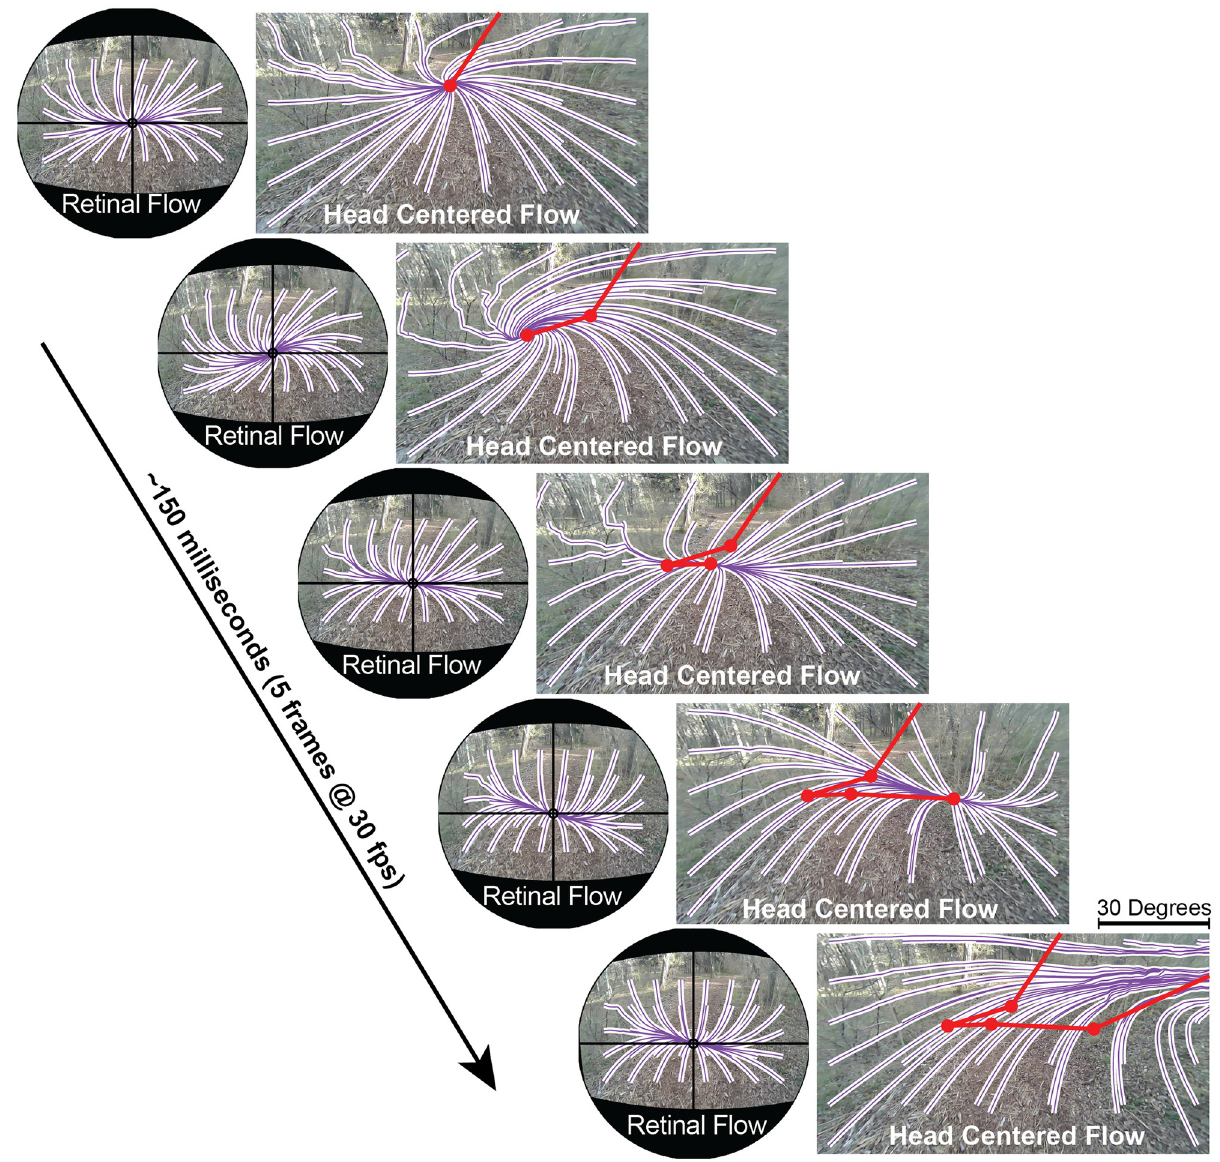
Fig 2. Retinal vs head-centered optic flow. Optic flow patterns (down-sampled) for a sequence of 5 video frames from S3 Video, altered for visibility in print. Head centered flow shows optic flow in the reference frame of the head mounted “;world” camera, and represents optic flow free from the effects of eye movements. Retinal flow shows optic flow in the references frame of a spherical pinhole camera stabilized on the subject’s fixation point. Purple and white lines show the integral curves of the measured flow fields, determined by using the streamlines2 function in Matlab to make a grid of particles drift along the negation of the flow fields measured by the DeepFlow optical flow detection algorithm in OpenCV. The red trace shows the movement of the head-centered FoE moving down and to the right across the 5 frames. In contrast, note the stability of the retina-centered flow over the same period.